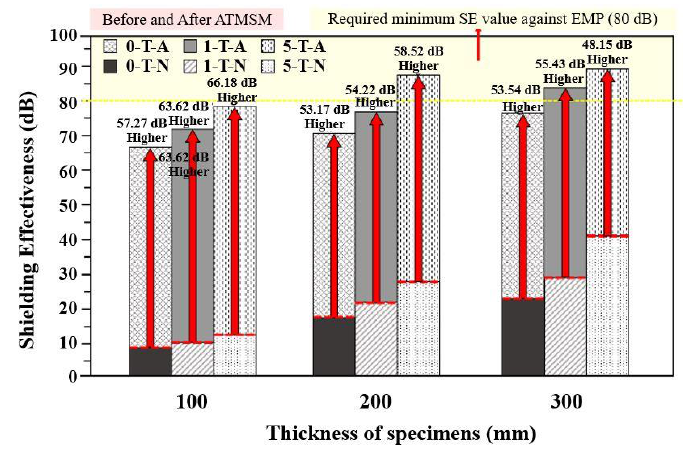
Figure 7. Electromagnetic shielding performance after application of the Zn–Al metal thermal spray coating.